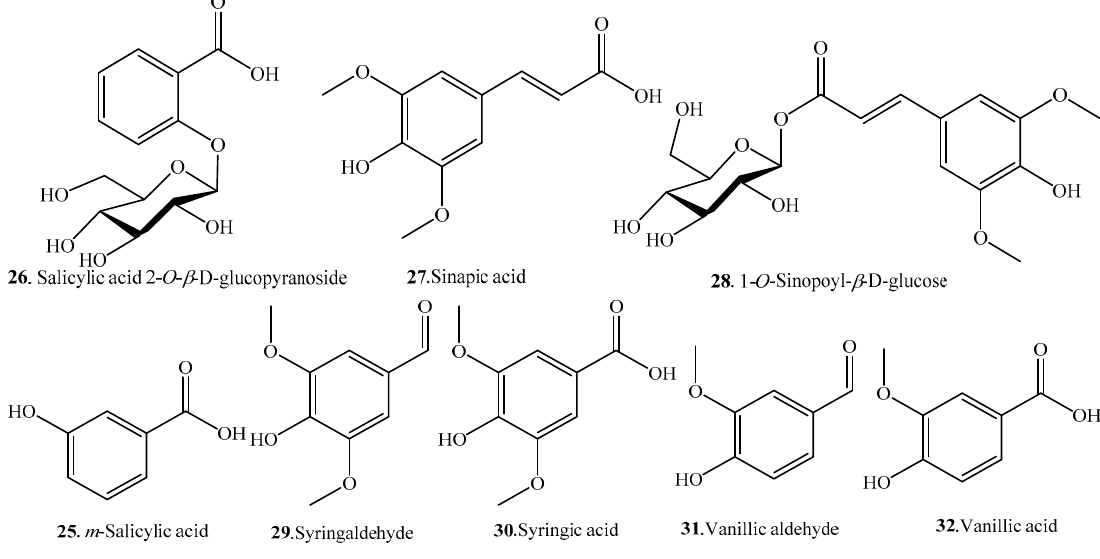
Figure 1. Structures of the phenolic acids isolated from rice.